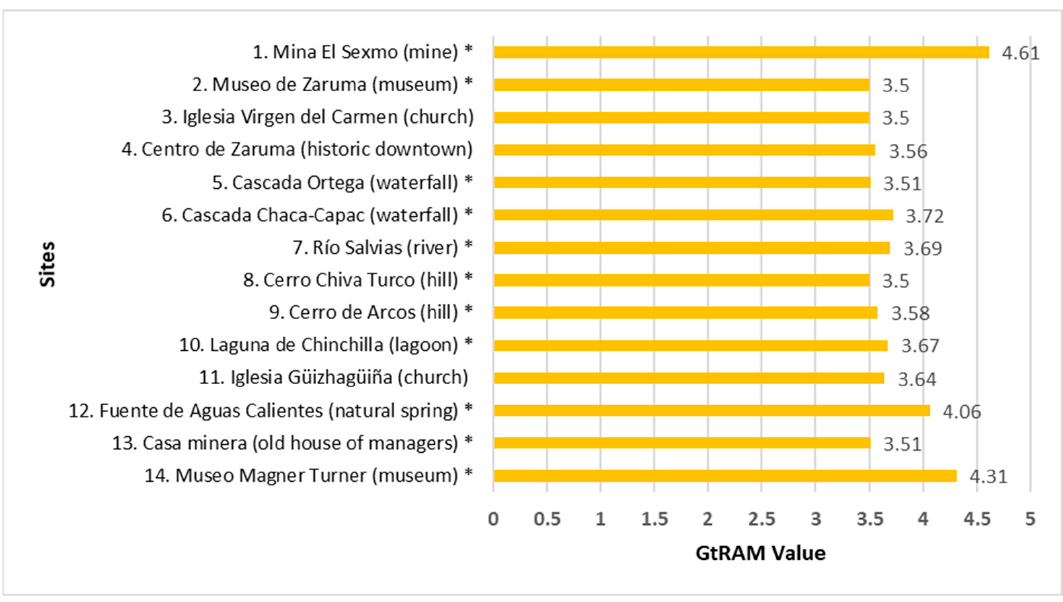
Figure 9. GtRAM evaluation of the geosites and mining sites that make up the GM-III route. * Geosites/mining sites.